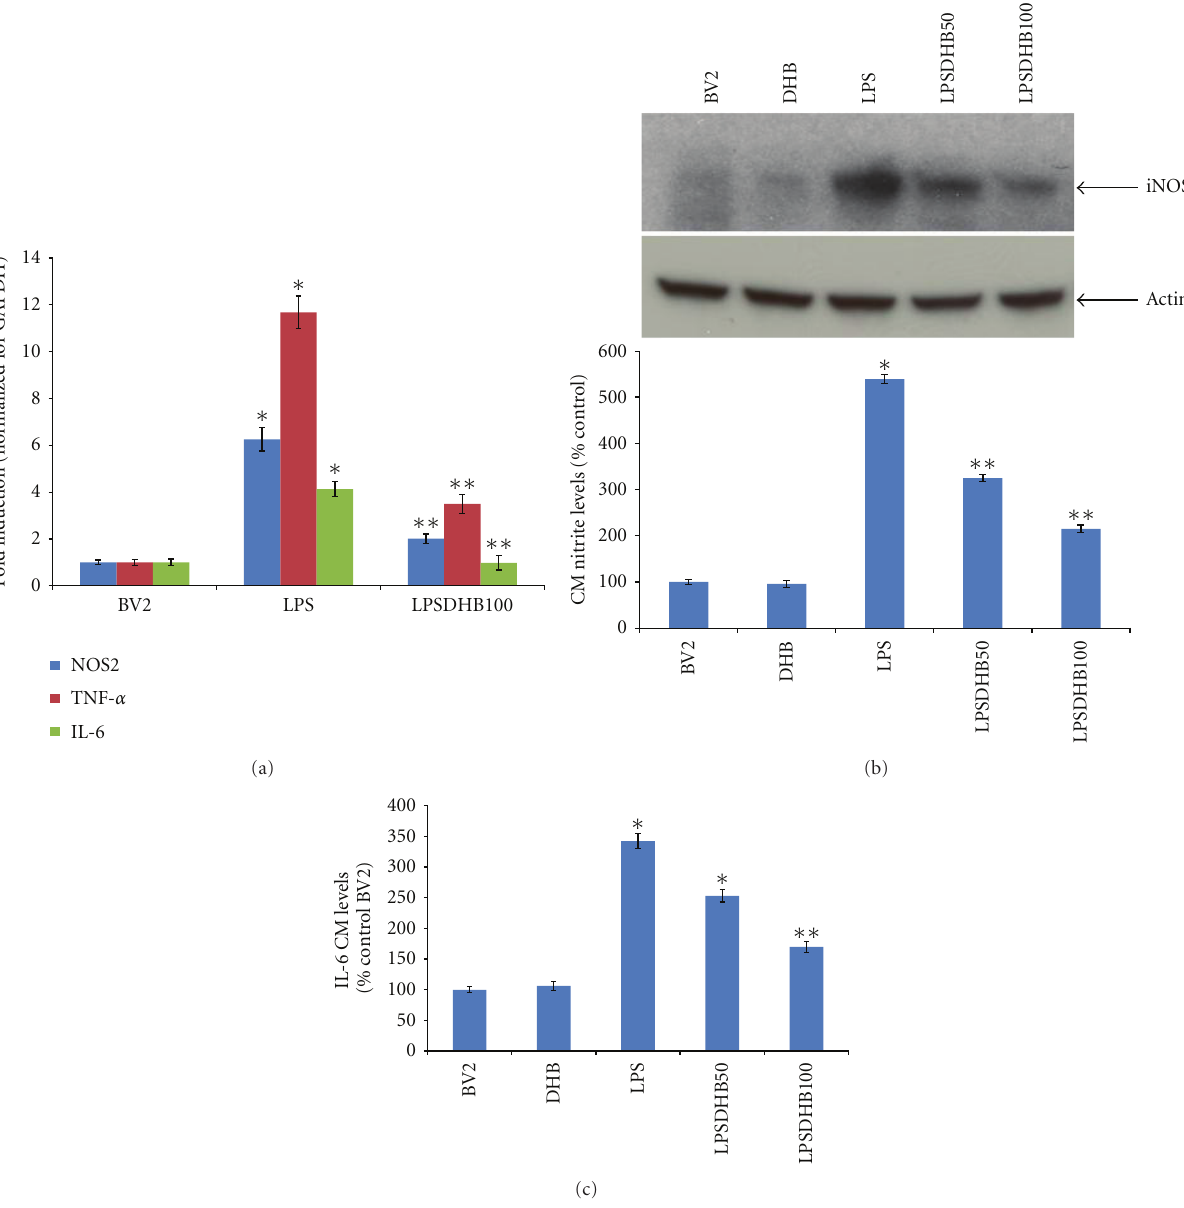
Figure 1: (a) BV2 microglial cells were pretreated with DHB (100 μ M) for 1 h followed by cotreatment with LPS (100ng/mL) for 6h. Total RNA was isolated and real-time PCR analysis performed. Relative mRNA levels for iNOS, TNF- α , and IL-6 were normalized for GAPDH. Each bar represents means ± SEM. ∗ P < 0 . 05 compared with the control group, ∗∗ P < 0 . 05 compared with the LPS-treated group. (b) Protein was extracted from whole cell lysates and subjected to western blot analysis for iNOS protein levels; actin was used as a loading control. Conditioned media (CM) was collected after 24 h LPS (100ng/mL) ± DHB treatment and nitrite levels determined using the Griess reagent. Data are presented as means ± SD of at least four independent experiments. ∗ P < 0 . 05 compared with the control group, ∗∗ P < 0 . 05 compared with the LPS treated group. (c) IL-6 levels in the CM were determined using an ELISA kit according to manufacturer’s recommendations. Data are presented as means ± SD of at least four independent experiments. ∗ P < 0 . 05 compared with the control group, ∗∗ P < 0 . 01 compared with the LPS treated